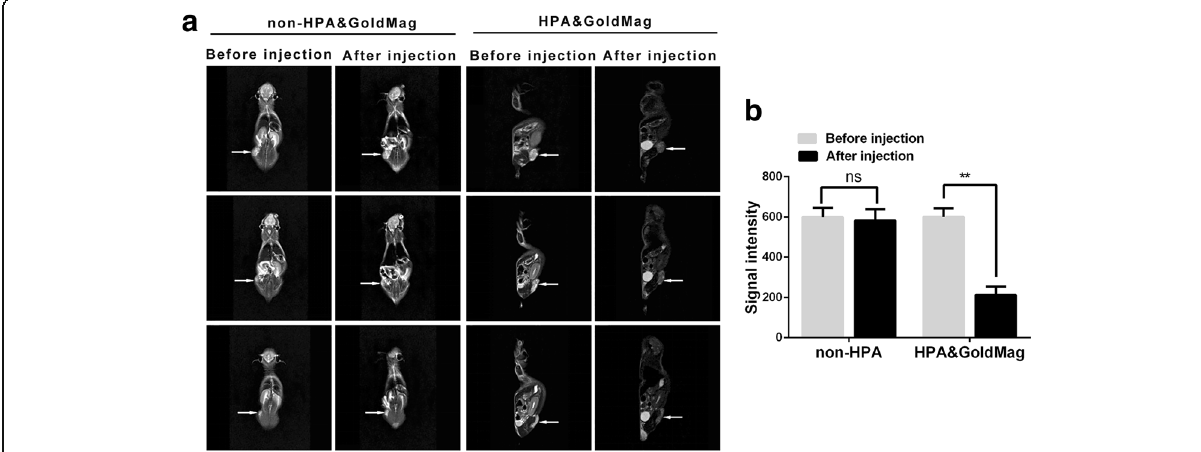
Fig. 5 a MR imaging of nude mice before and 2 h after the injection of control or HPA&GoldMag probes. The arrow indicates the tumors in mice. b Comparison of the signal strengths from MR images using T2WI before and after the injection of the control or HPA&GoldMag probes in nude mice. * P